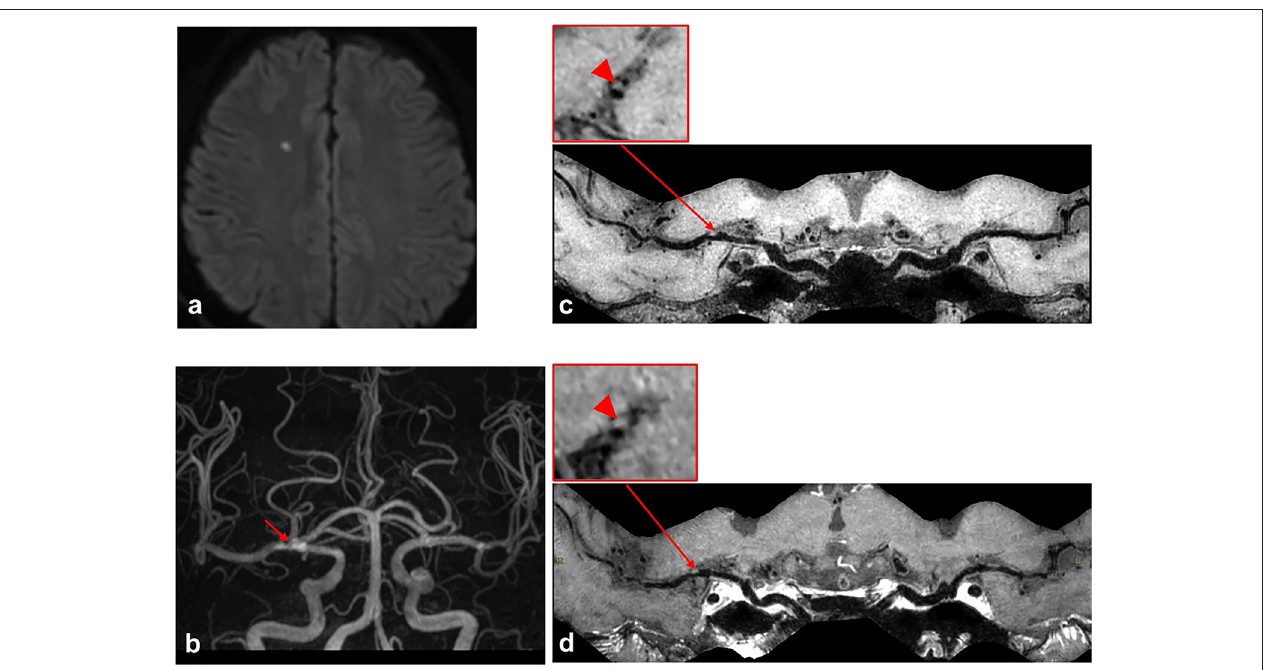
FIGURE 4 | A case with first-time acute stroke. A 68-year-old male patient with the first-time acute stroke. (a) Axial diffusion-weighted imaging detects high-signal-intensity lesion in the right corona radiata. (b) Time-of-flight magnetic resonance angiography image shows moderate stenosis on the M1 segment of right middle cerebral artery (MCA) (red arrow) and no stenosis on the left MCA. (c,d) Curved planar reconstruction images from pre-contrast and post-contrast whole-brain vessel wall imaging show a focal plaque in the right M1 segment of MCA. No obvious contrast enhancement is identified in the culprit plaque of the right MCA M1 segment (red arrowhead).